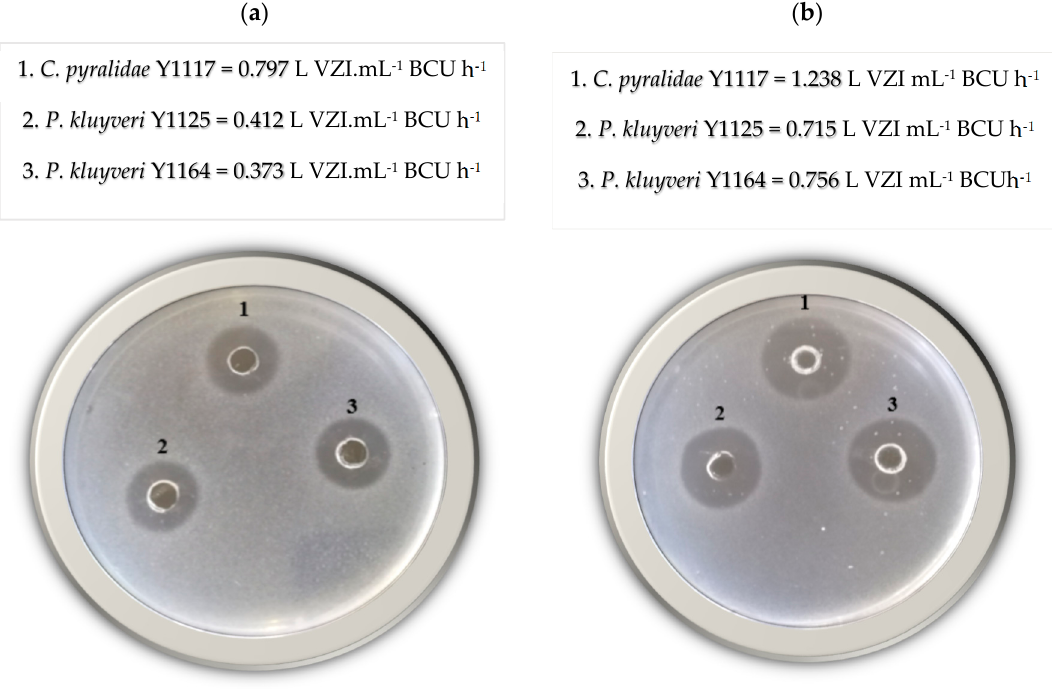
Figure 5. Growth inhibition assay plates showing the inhibition activity against D. bruxellensis before ( a ) and after ( b ) optimization of biopreservation compounds production by Candida pyralidae Y1117 (1), Pichia kluyveri Y1125 (2) and P. kluyveri Y1164 (3).